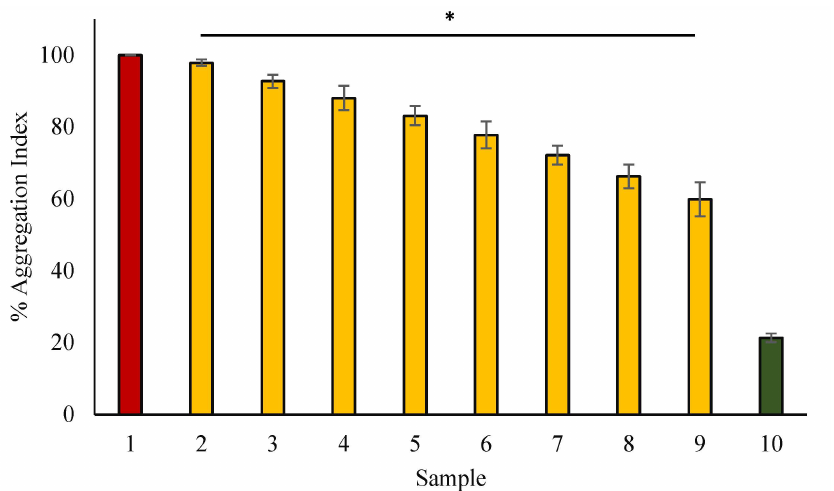
Figure 7. Decrease in aggregation index in presence of myrrh methanolic extract. Sample 1 is BSA treated with glucose for 15 days and is thought to have the highest aggregation index and hence the highest glycation aggregation index. Samples from 2 to 9 contained 50, 75, 100, 200, 300, 400, 500, and 600 µ g/mL of myrrh extract. Sample 10 contained BSA incubated without glucose and myrrh and exhibited the minimal aggregation index. The data are shown as means ± standard error of the means (n = 3, p < 0.05). The statistical differences are represented with an asterisk (*) for myrrh denoting significance at p < 0.05 in comparison with the reference sample.